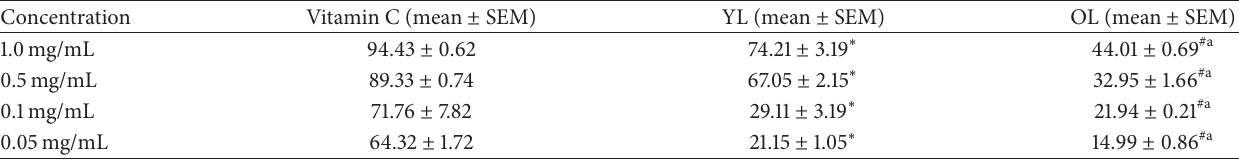
Table 2: Total antioxidant activity between the old and young leaf extract.